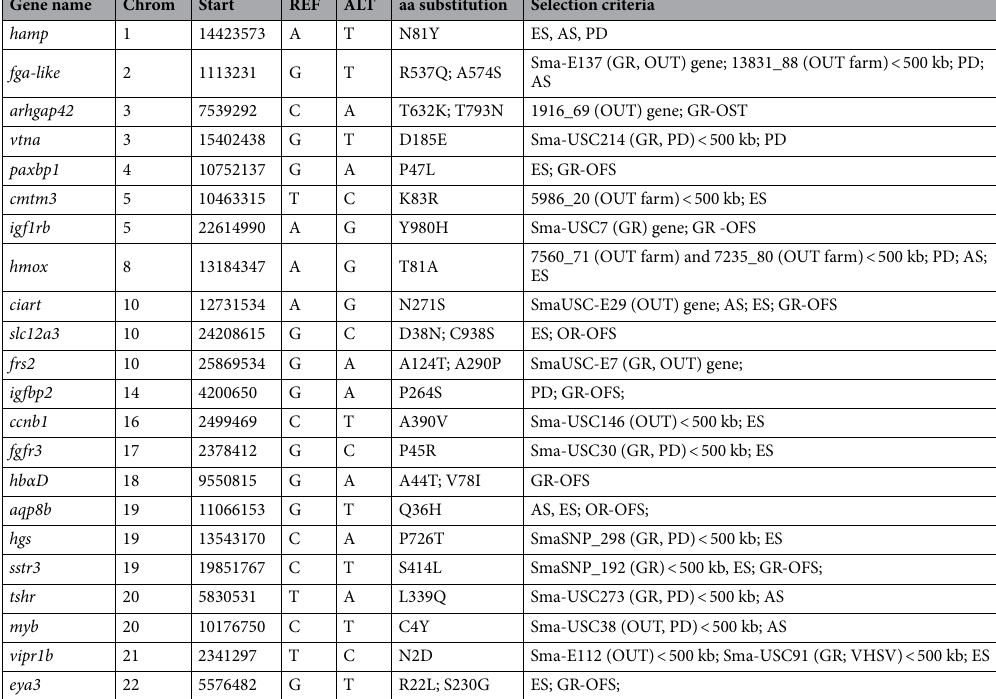
Table 2. Selection of non-synonymous variants in turbot ( Scophthalmus maximus ) candidate genes following functional criteria. REF/ALT: reference and alternative alleles; selection criteria: differentially expressed genes for resistance to E . scophthalmi (ES), A . salmonicida (AS) and P . dicentrarchi (PD); genetic markers associated with QTL for growth (GR) or resistance to the same pathogens (ES, AS, PD), and to outliers (OUT) for natural or artificial (farm) selection within the gene (gene) or at less than 500 kb from the gene (< 500 kb); other fish- studies (OST) including osmoregulation (OR) and growth